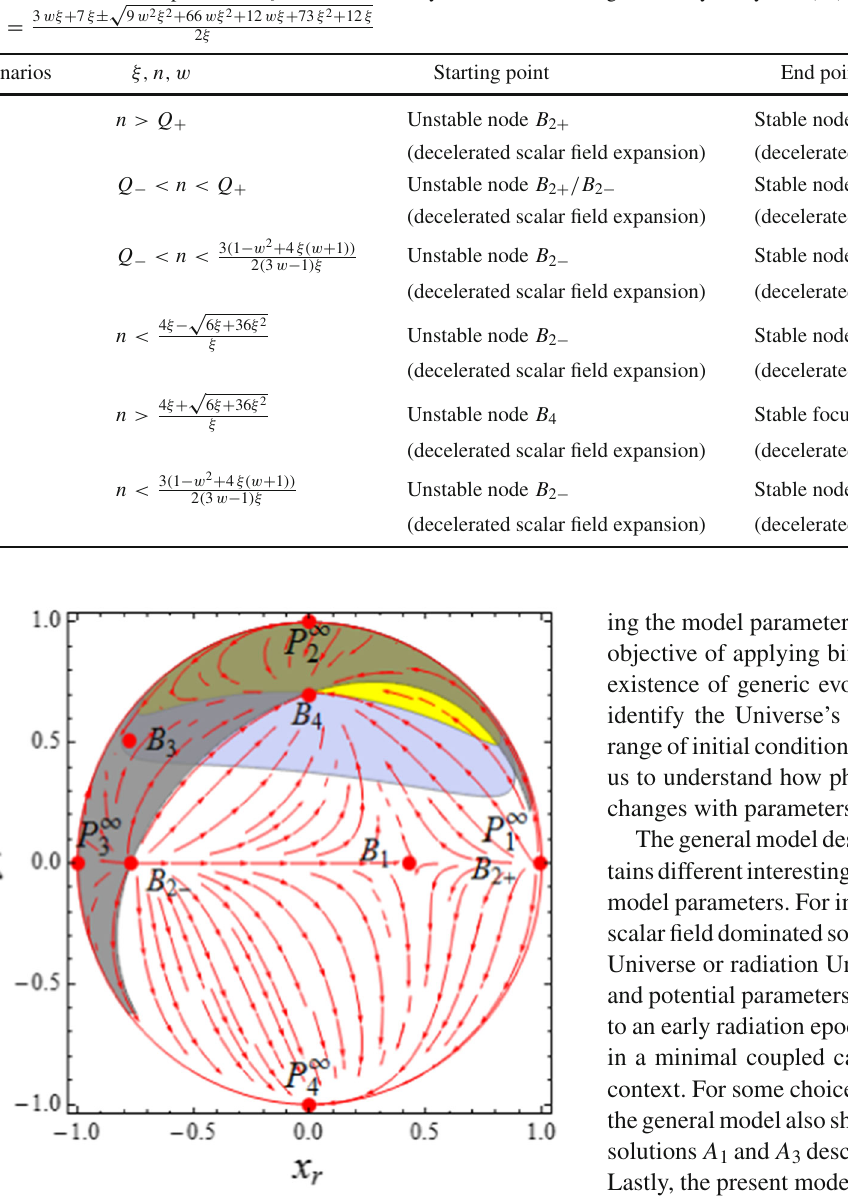
Table 4 Conditions on parameters ξ, n ,w for which dynamics of Universe governed by the system (37)–(38) undergoes a generic evolution. Here,